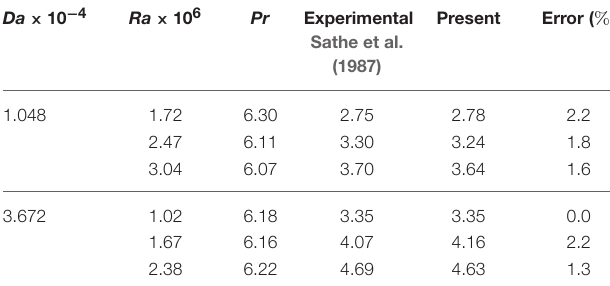
0.71: (A) Ra 10 7 , (B) Ra 10 8 , and (C) Ra 10 9 while ǫ 0.9999 and Da 10 8 . = = = = = = TABLE 3 | Comparison of the present average Nusselt number, Nu for ǫ 0.5, = with the previous experimental results of Sathe et al. (1987) in a tilled cavity with porous media while the aspect ration A =